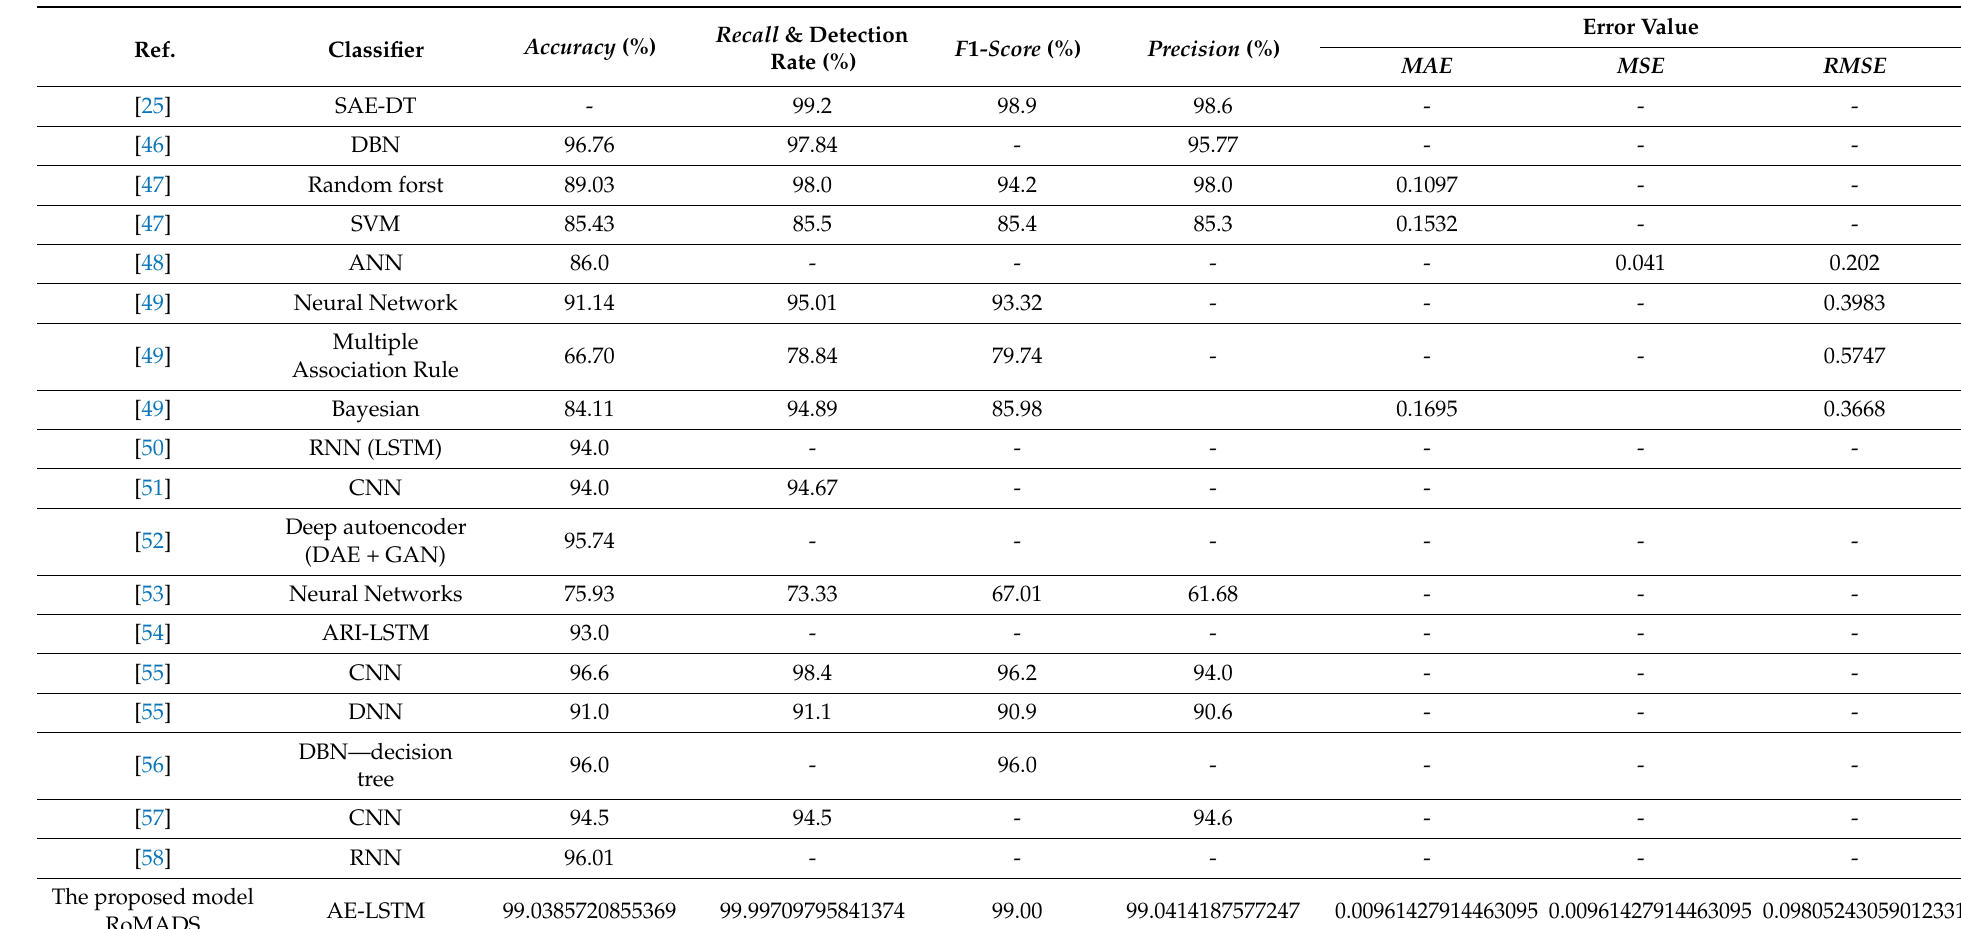
Table 4. Comparison between RoMADS model result and the previous paper’s